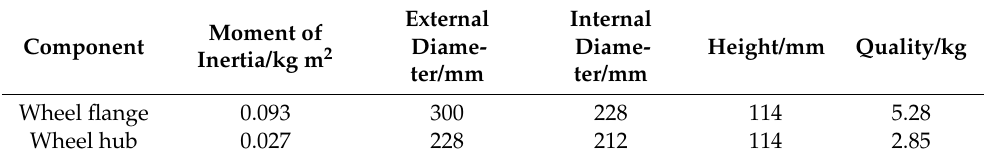
Table 3. Geometric parameters of flywheel